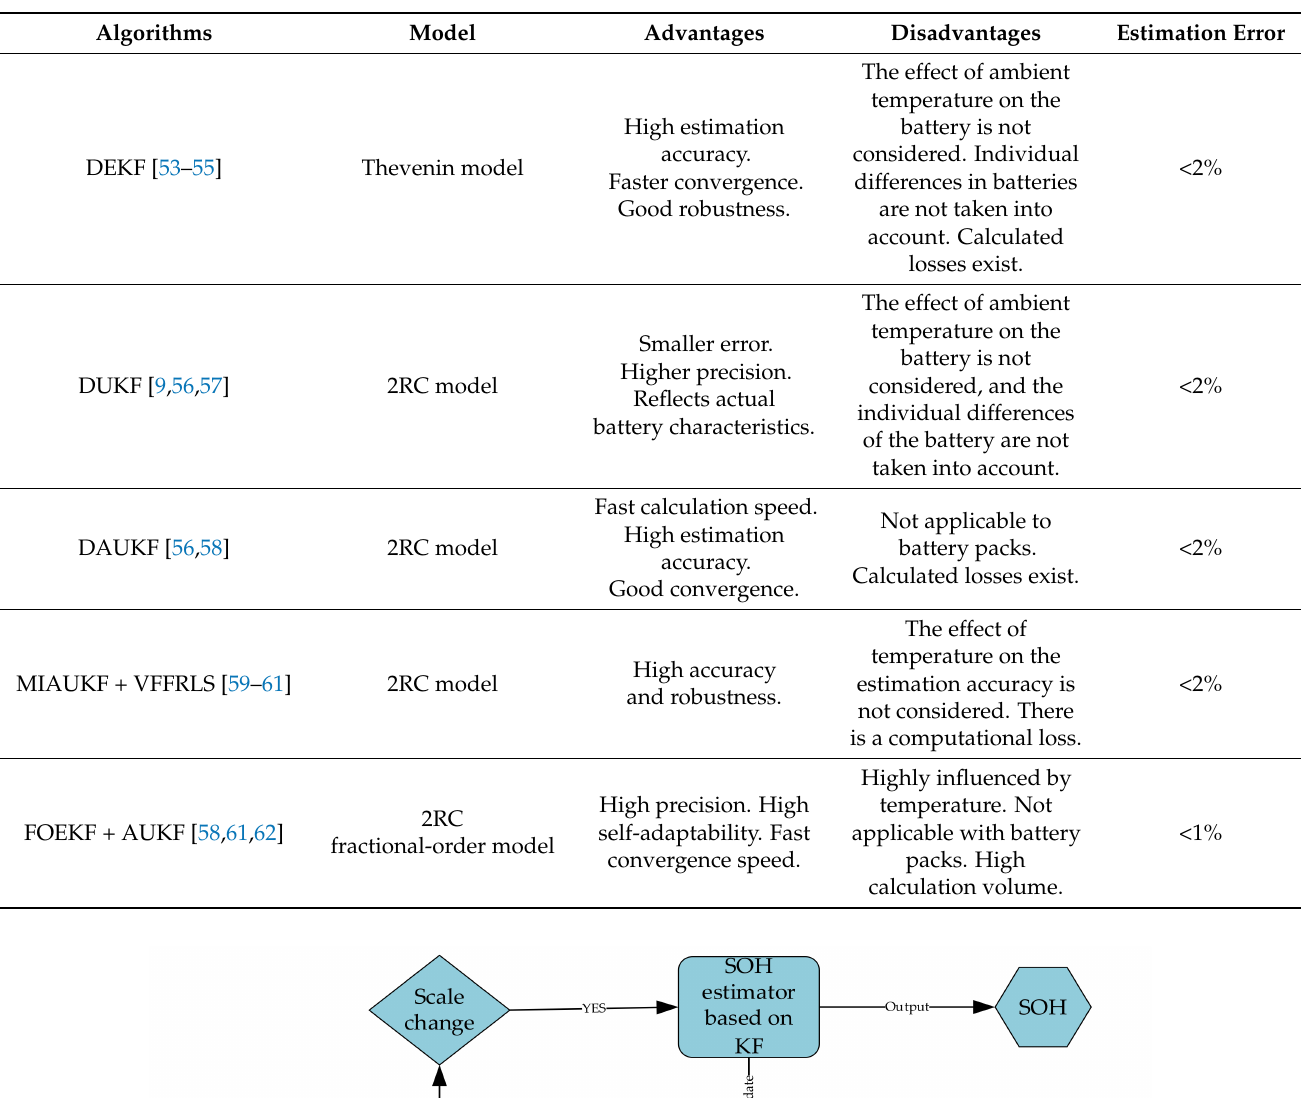
Table 5. Joint SOC/SOH estimation at the same time scale.